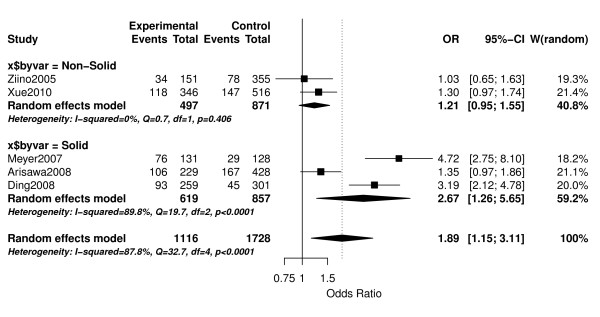
Meta-analysis of Mif promoter region polymorphism (-173 G/C) and cancer. Point estimates of the Odds Ratio (OR) and accompanying 95% confidence intervals are shown for each study. Overall analysis using Random effects model and subgroup analyses for patients with "Non-Solid" vs. "Solid" tumors are shown.